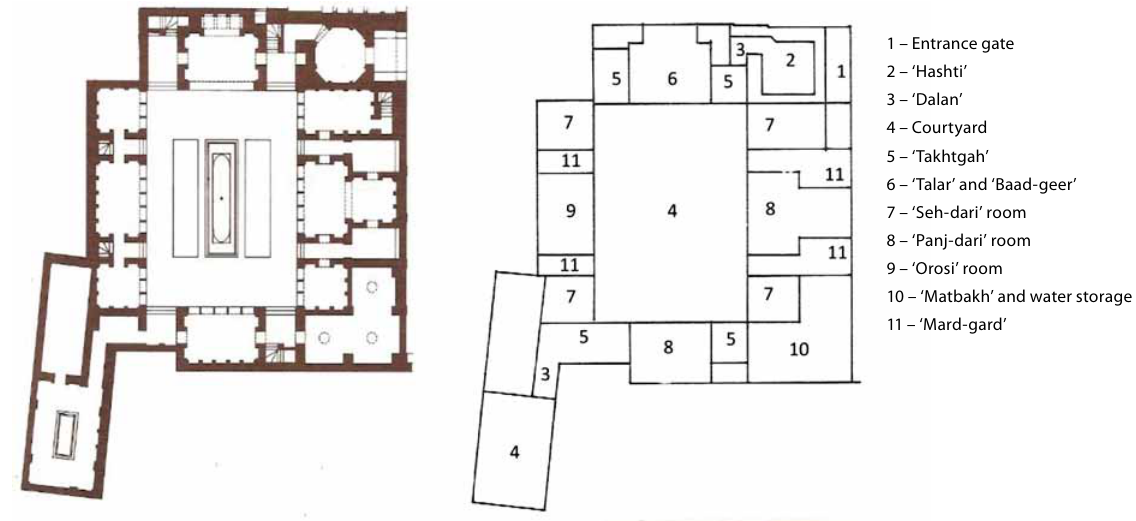
fig. 5. Settlement of the components of a TPH in Gazorgah neighborhood in Yazd, Ghezelbash and abouzia, 1985, p.